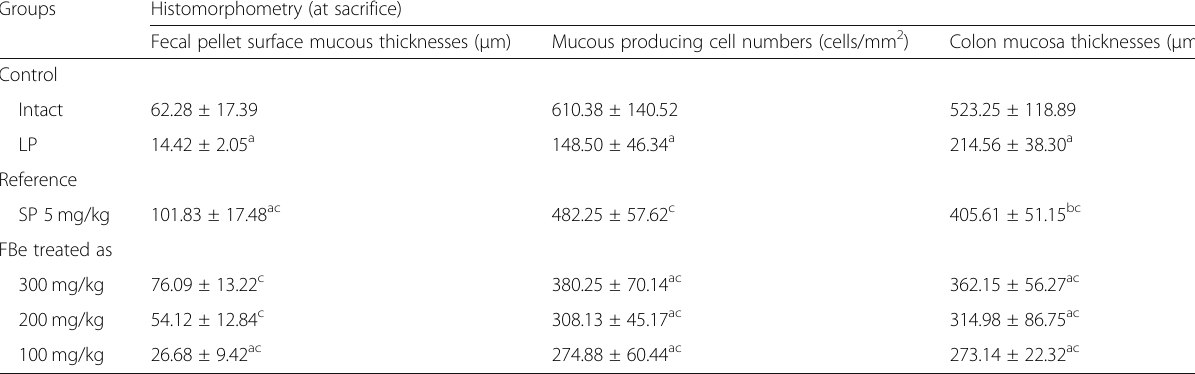
Table 5 Histomorphometrical analysis of the colon and remnant fecal pellets in the constipation rats induced by LP Groups Histomorphometry (at